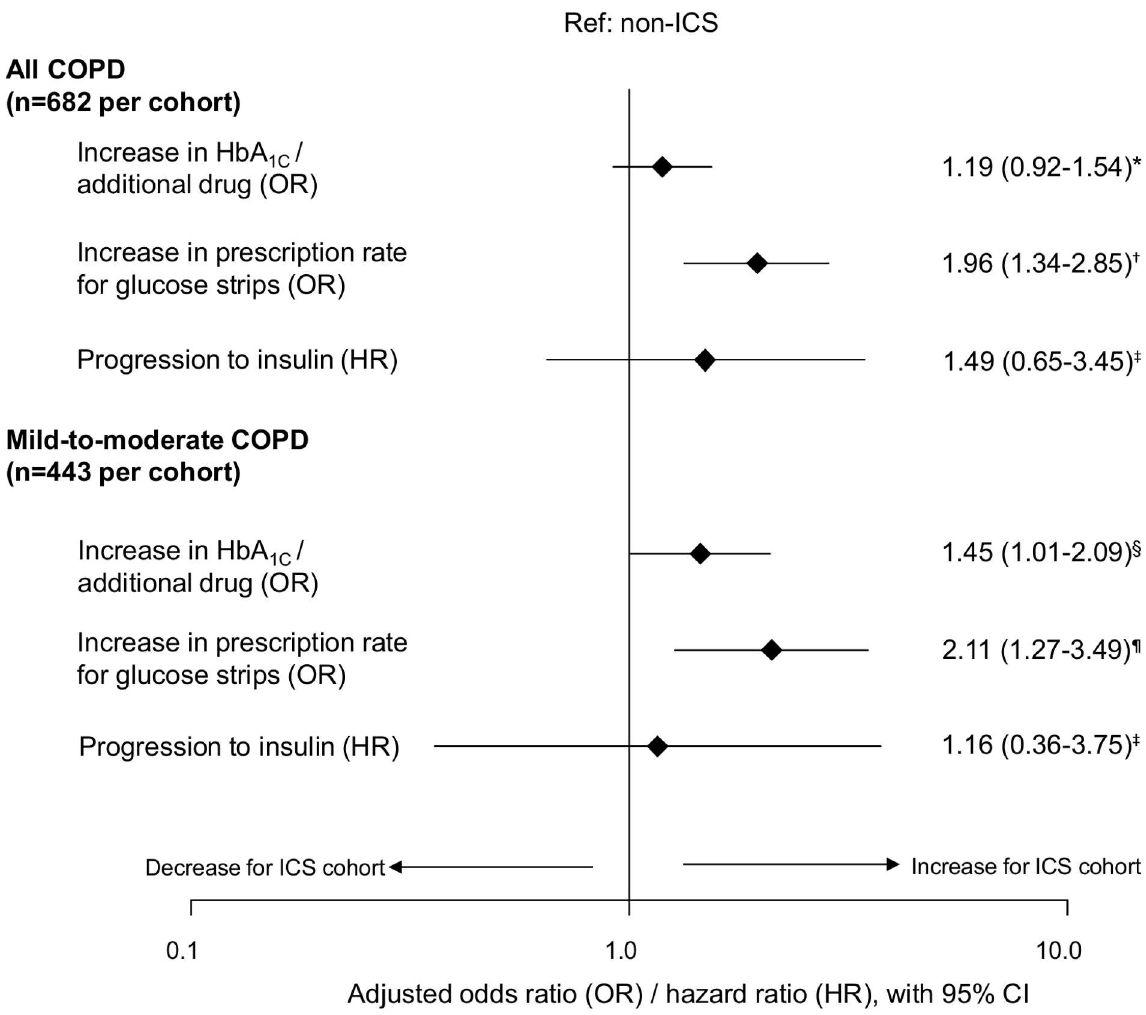
Fig 2. Comparison of other diabetes-related outcomes between ICS and non-ICS cohorts. Mild-to-moderate COPD patients identifiedby GOLD groups A and B. * Adjusted for diagnosisof GORD in baseline,duration of diabetes, time between baselineand outcome HbA 1c readings, and acute OCS use between index date and outcome HbA 1c readings. † Adjusted for number of allergy prescriptions and number of primary care consultationsin baseline. ‡ Adjusted for baselineantidiabeticmedication. § Adjusted for number of COPD consultations in baseline,time between baselineand outcome HbA 1c readings, and acute OCS use between index date and outcome HbA 1c readings. ¶ Adjusted for number of GP consultations in baseline.CI = confidenceinterval; COPD = chronic obstructive pulmonary disease; HbA 1c = glycated haemoglobin; ICS = inhaledcorticosteroids; GORD = gastro- oesophageal reflux disease; GOLD = Global Initiative for Chronic Obstructive Lung Disease; GP = generalpractice; OCS = oral